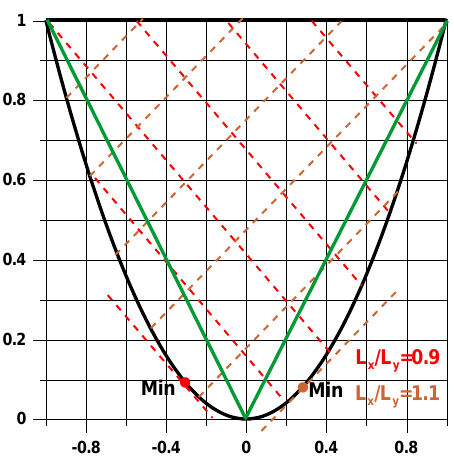
Figure 7. Distributions of eigenfrequencies for angle-ply clamped (CCCC) plates.